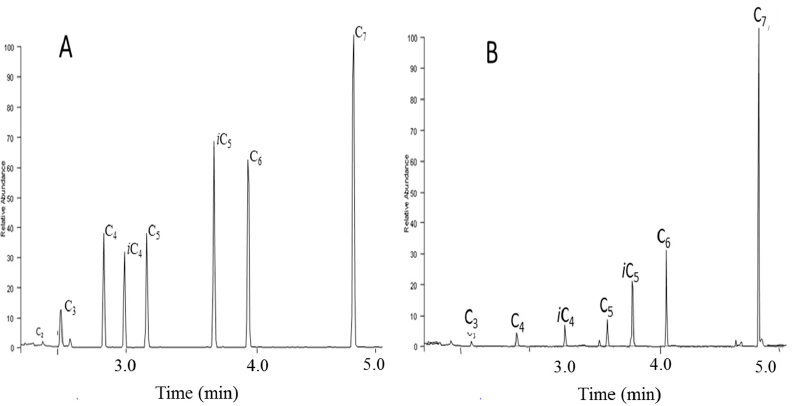
Figure 4. Spectral ionic mass (SIM) chromatogram of liquid/liquid ( A ) and direct immersion solid phase microextraction (SPME) ( B ) optimal recoveries of iso molar low molecular weight fatty acid methyl esters.